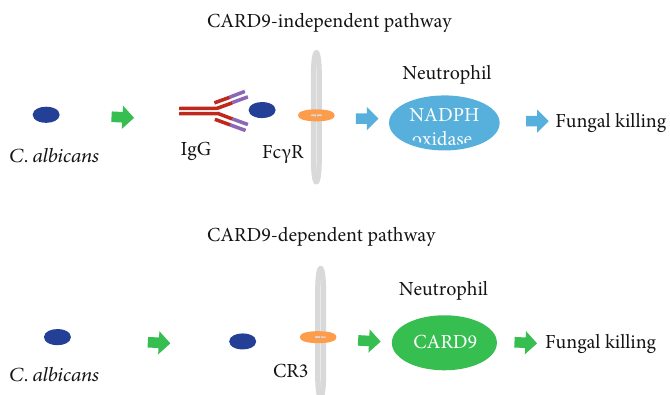
Figure 1: Neutrophils kill fungus via CARD9-dependent or independent mechanisms. Neutrophil-mediated killing mechanisms, either via CR3 or the Fc γ receptors, depended on fungal recognition. The killing capacity of CARD9-de fi cient neutrophils could be restored by opsonization of C. albicans with human IgG antibody.